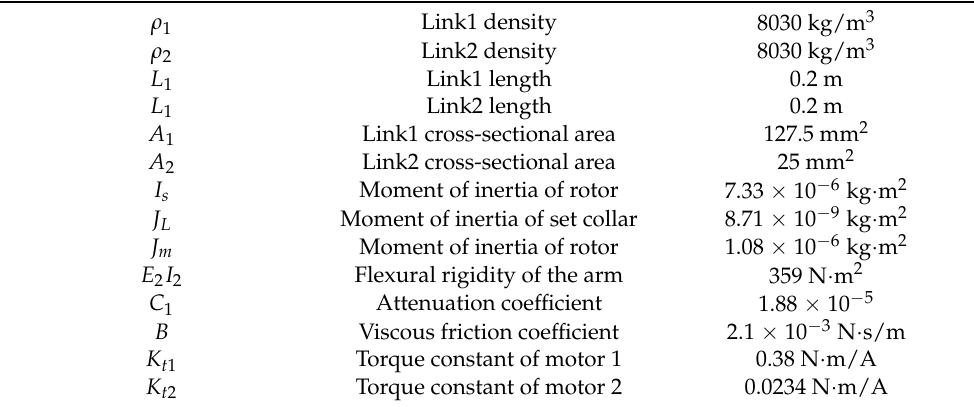
Table 2. Laboratory equipment